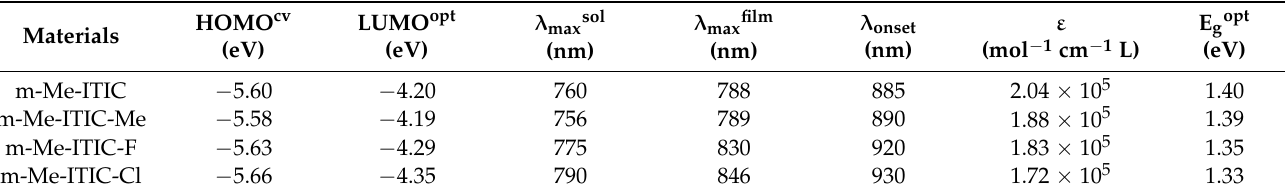
Table 1. Optical and Electrochemical Properties of acceptors.